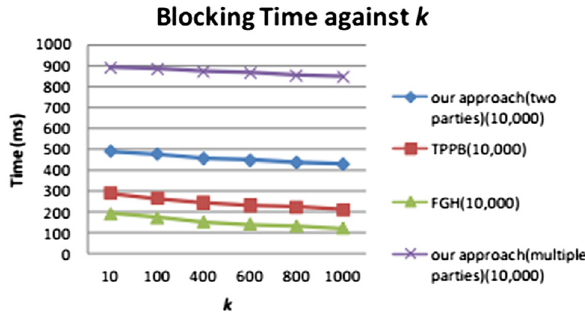
Fig. 10 Blocking Time with different dataset sizes for the four approaches